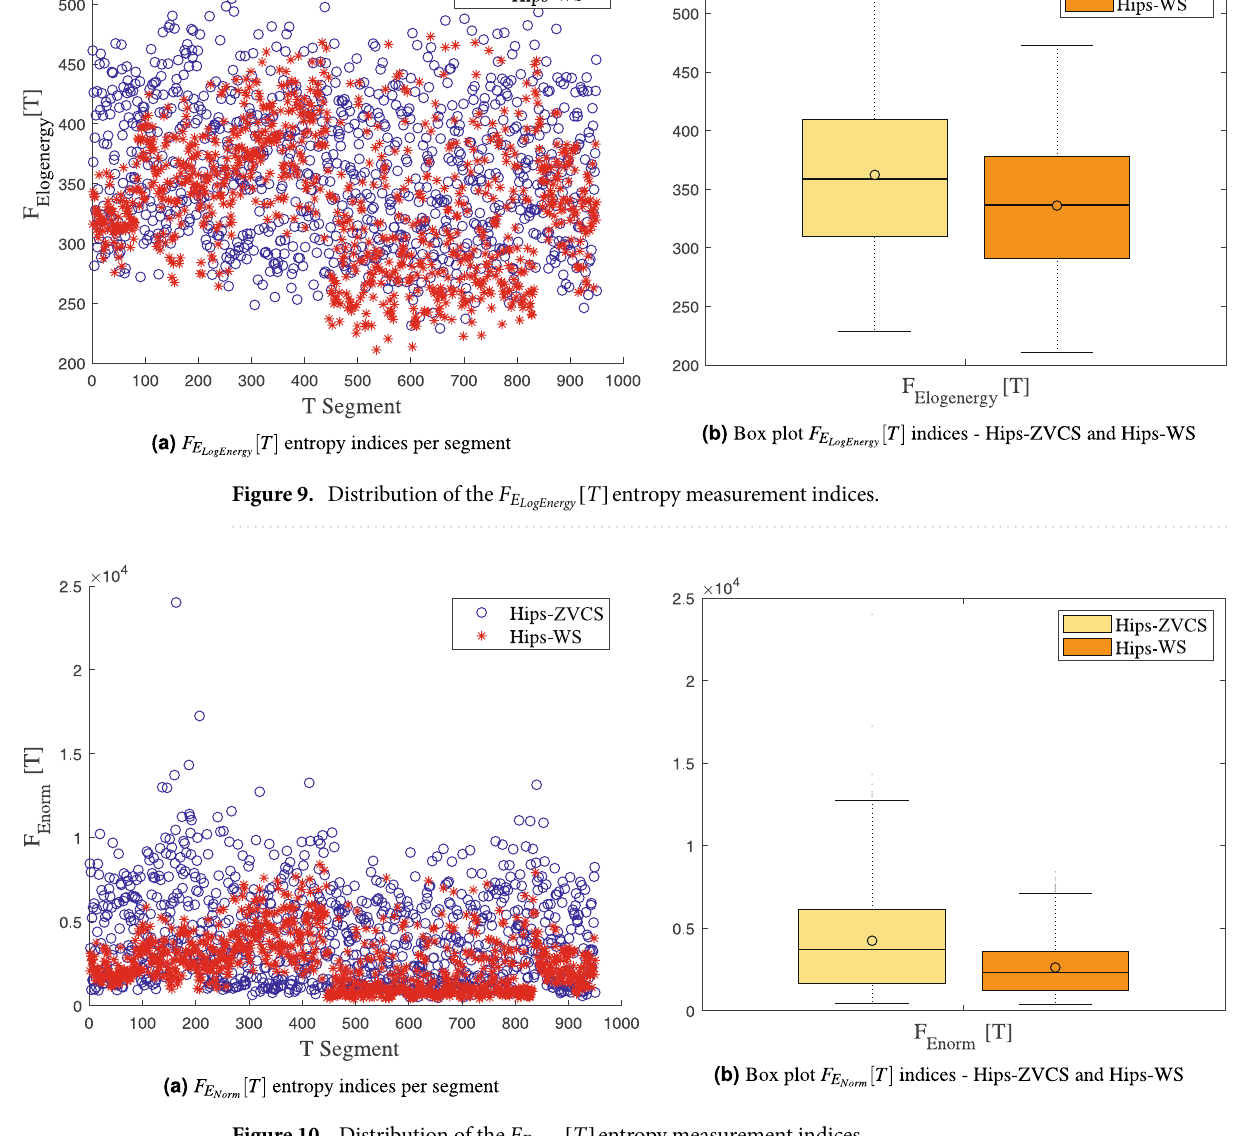
Figure 10. Distribution of the F E